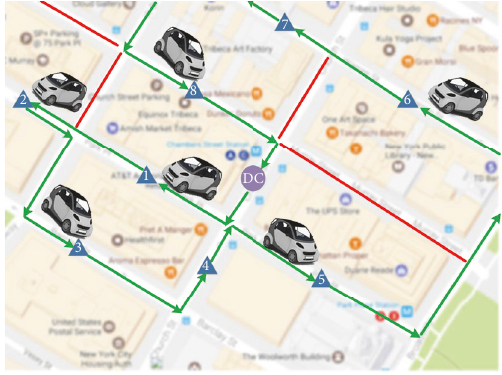
Figure 1: AVRPTW model